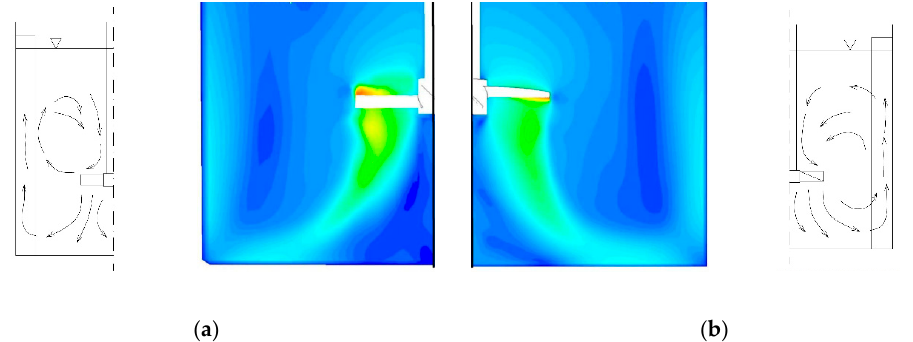
Figure 5. Flow in agitated batch with: ( a ) standard axial inclined blade turbine; ( b ) axial hydrofoil impeller (sketch of flow pattern [10], contours of velocity field; red is max. value and dark blue is min. value of flow